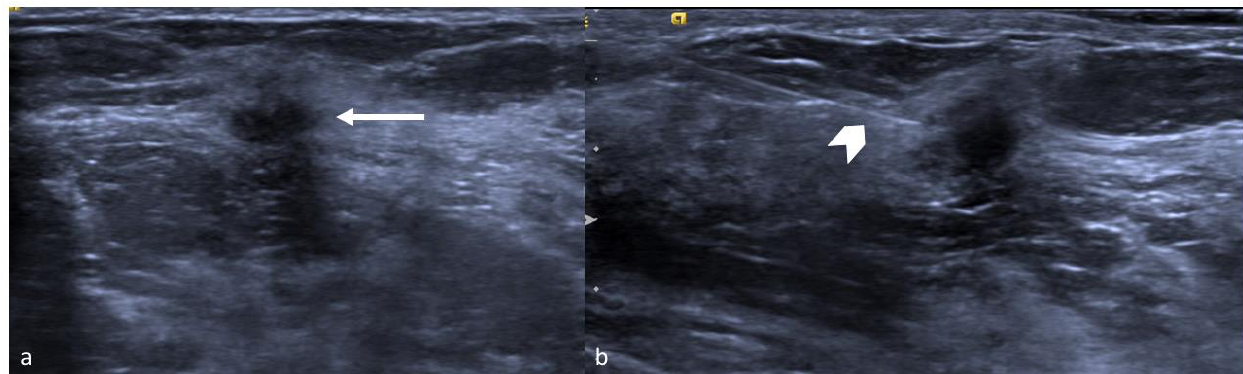
Figure 2. Radio-guided occult lesion localization (ROLL) technique: ( a ) invasive ductal cancer (arrow) in the left upper outer quadrant in a 77-year-old woman. ( b ) Intratumoral injection (arrow head) of a small amount (0.2–0.3 mL) of human serum albumin marked with nuclear radiotracer technetium 99 in order to perform radio-guided occult lesion localization.